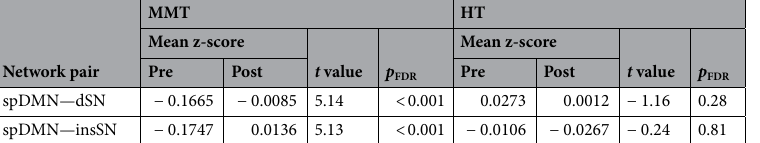
Table 2. Fisher r-to-z transformed correlation values of spDMN and dSN as well as spDMN and insSN within state five before and after the intervention for both groups and results of paired t-tests, p value corrected